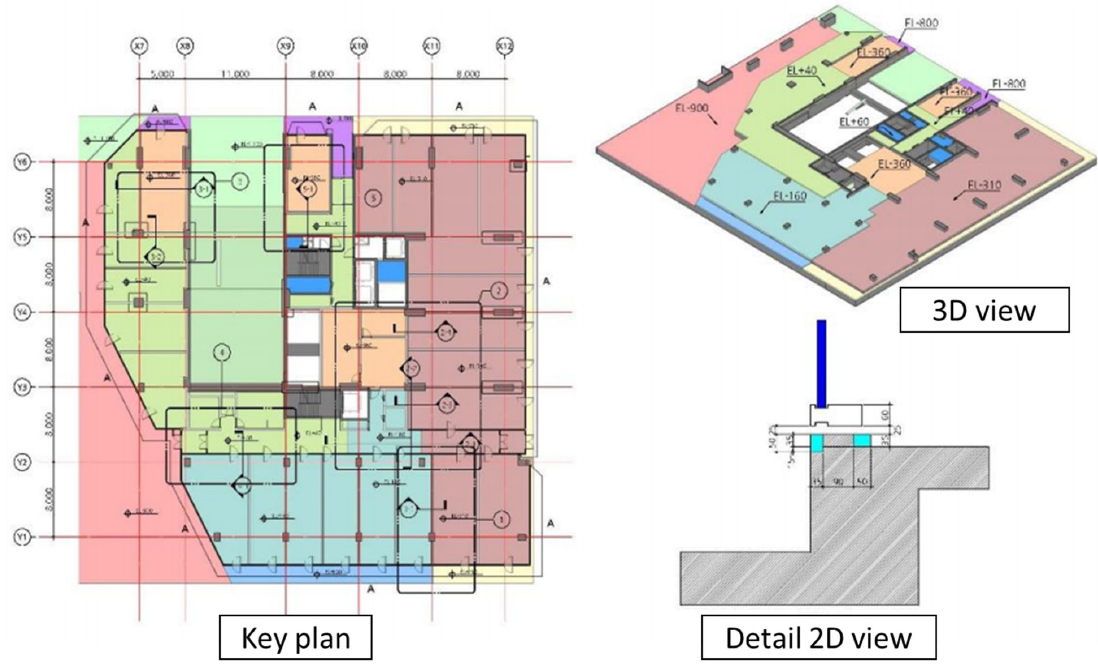
Figure 4. A review case of level utilizing a combination of detailed information included in a floor plan, 3D view, and 2D detail drawing.